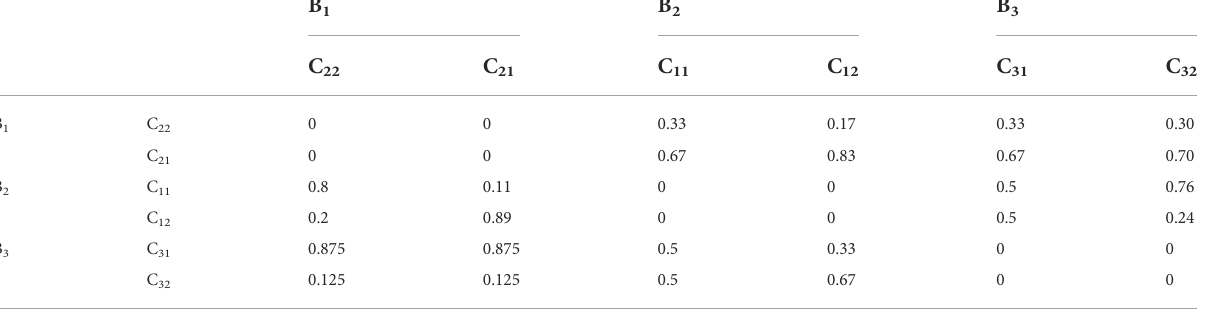
TABLE 4 Weighted matrix.